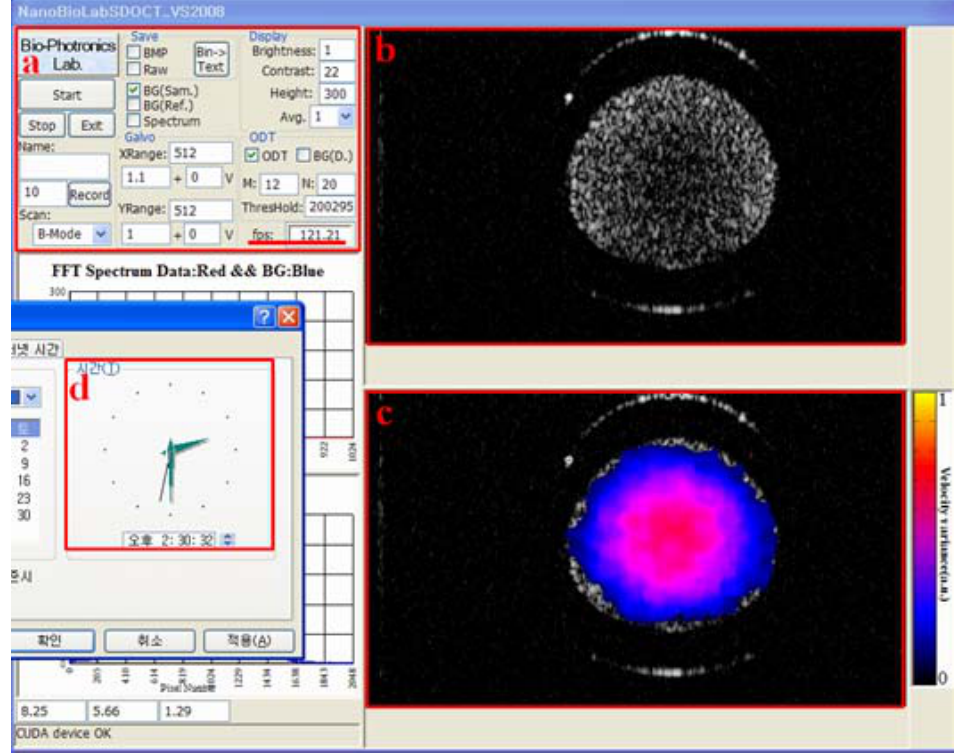
Figure 9. Captured movie of experiment for a capillary tube ODT. Doppler angle: 80°. Averaging window size: 12 + 20 ( M + N ). Displaying image size: 512 W × 300 H pixel. ( a ) System setup. Red line: actual frame rate; ( b ) OCT image; ( c ) ODT image; ( d ) The watch for time